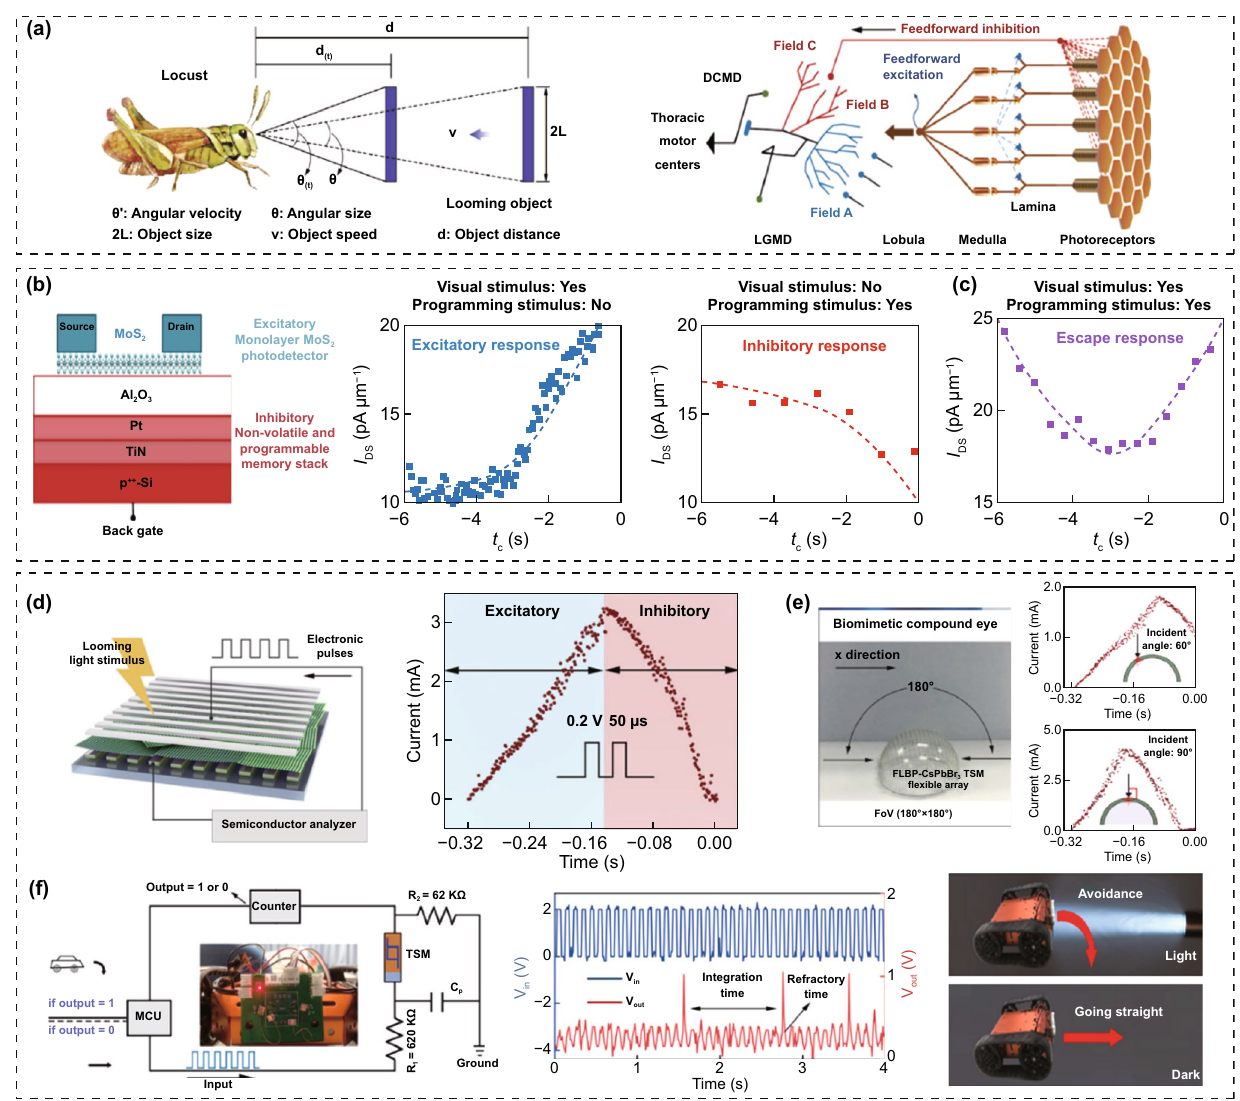
Fig. 13 a Biological collision avoidance system. b , c Neuromorphic collision sensor using MoS 2 photodetector and FG transistor‑type ES: b device schematics with light‑driven exhibitory and bias‑driven inhibitory functions for collision sensing and c characterization curve for colli‑ sion‑avoidance decision‑making. d – f Neuromorphic collision sensor using memristor‑type OS: d device schematics, e position‑dependent col‑ lision detection performance of collision sensors placed on compound eye, and f proof‑of‑concept of a collision avoidance system built using a neuromorphic collision sensor and an Arduino microcontroller. b , c Reproduced with permission from Ref. [107]. Copyright @ 2020, Springer Nature. a , d – f Reproduced with permission from Ref. [108]. Copyright @ 2021, Springer